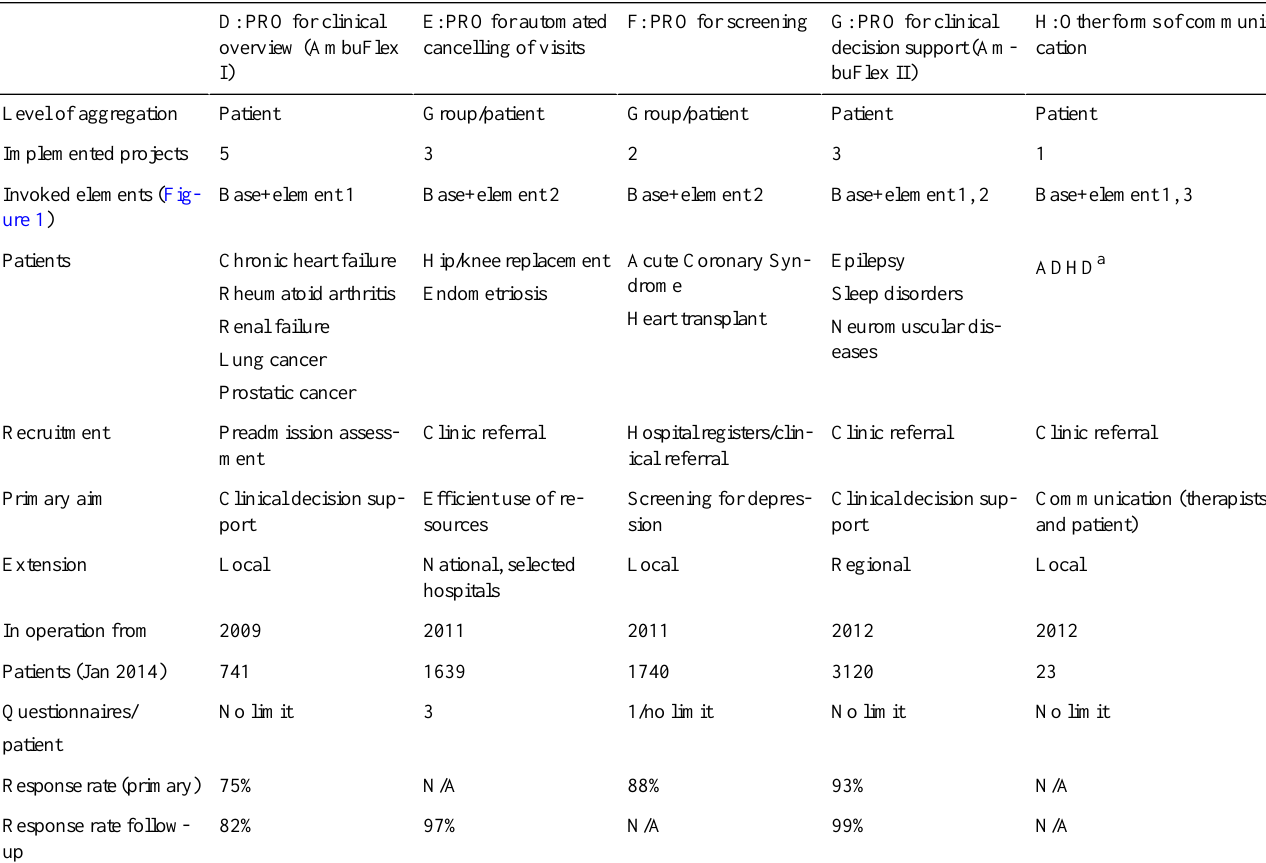
Table 3. Characteristics of 22 projects involving implementations of a generic PRO system. Projects with patient level use (n=14).